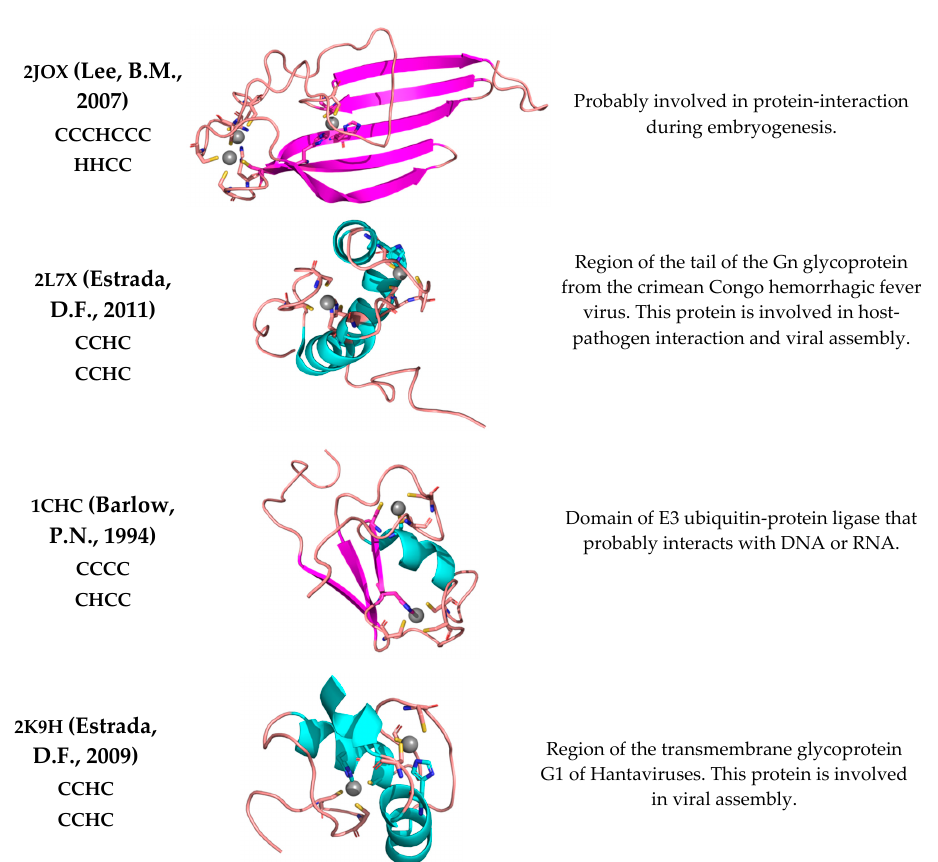
Figure 2. Mean S 2 of 2NAX and standard deviation (SD) for bonded (red) and nonbonded (green) simulations superimposed to Het-NOE data (purple). Orange squares represent the position in the sequence of zinc(II)-binding Cys residues, whereas the green squares represent zinc(II)-binding His residues. The mean S 2 values computed from the MD runs with the two FFs are almost the same, with a remarkably similar trend over the protein sequence. Moreover, both com- puted S 2 display, as expected, high values (>0.7) for regions of secondary structure and lower values for loop regions, identifying a rigid domain in both cases. The ligands par- ticipating in metal coordination are encompassed in regions with higher stability than the protein average, whereas the N- and C-termini and loop regions experience significant flexibility. Additionally, with respect to the experimental Het-NOE data, we observed a fully satisfactory agreement, which can be quantitatively expressed by computing the Pearson coefficient. For the 2NAX protein, we obtained a coefficient of 0.82 for the NBFF and of 0.89 for the ZAFF (Table 1). Besides the protein termini, the Het-NOE indicates the presence of a rigid domain, as described above, except around residue 558, which is well captured by our simulations. The simulations with the NBFF display higher than expected